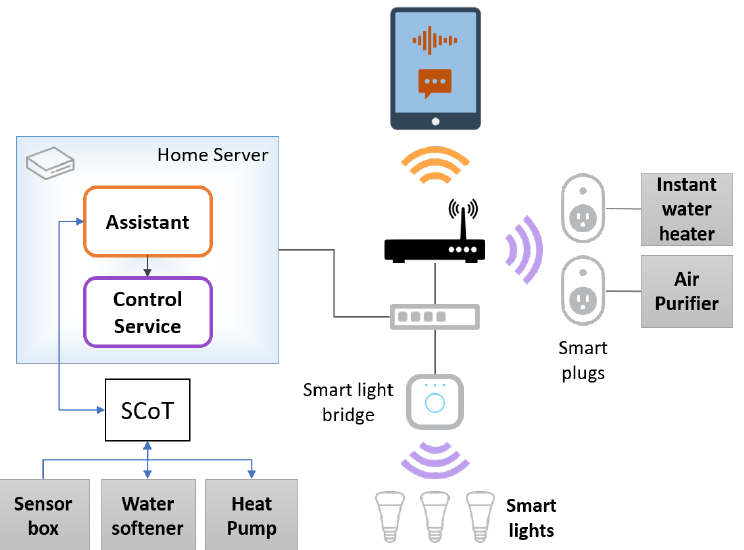
Figure 1. Architecture of the demonstrator, including the home assistant (running in the home server and accessible through a mobile device, such as a tablet) and the different home’s